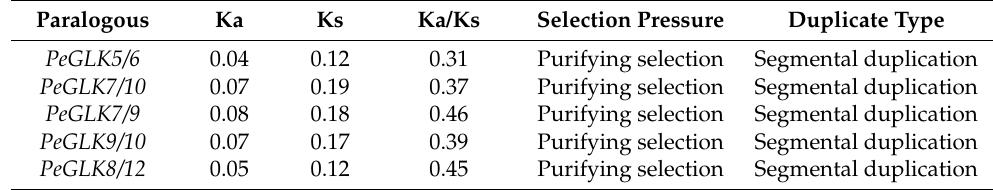
Figure 7. Duplication events of GLK proteins. ( A ) Synteny of moso bamboo PeGLK genes. ( B ) Synteny of moso bamboo and maize GLK genes. All syntenic genes were located on a map; segmentally duplicated GLK gene pairs are linked by red lines and tandemly duplicated genes by purple lines. Table 2. Ka/Ks and divergence analysis of paralogous PeGLK genes in moso bamboo.